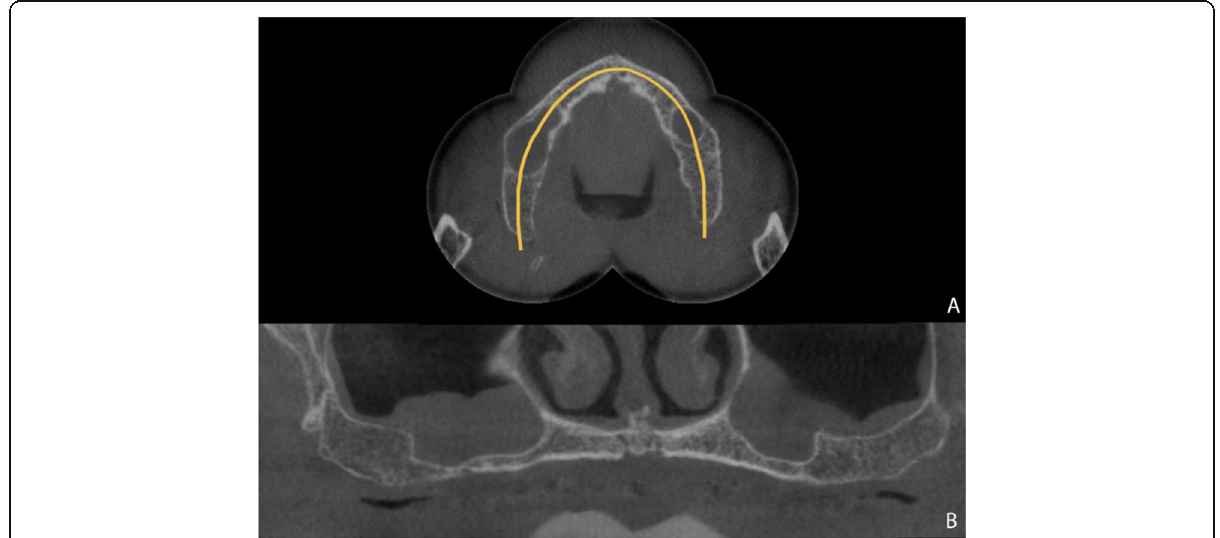
Fig. 2 Maxillary computed tomography. a Axial view. b Coronal